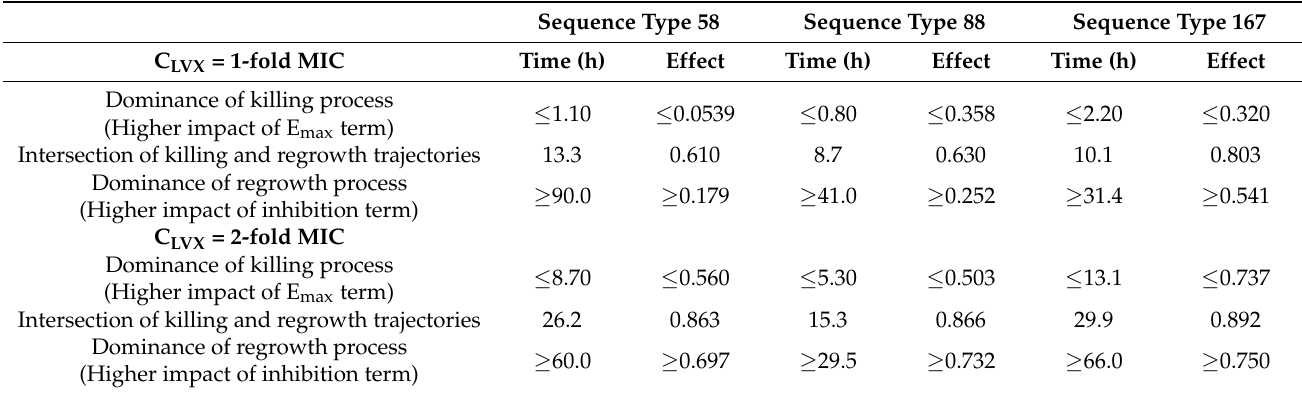
Table 3. Dominance * of killing and regrowth processes in the three different phases of the effect–time trajectories (see Figure 3, red vertical lines in lower left panel) of three Escherichia coli isolates under exposure to static levofloxacin (LVX) concentrations (1- and 2-fold the minimal inhibitory concentration (MIC) of the isolate), based on parameter estimates stratified per exposure